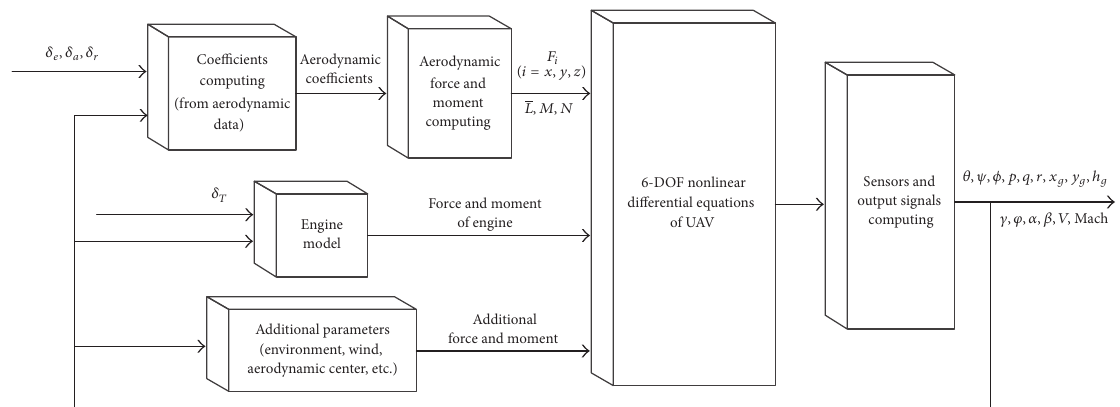
Figure 1: The inner structure of the UAV